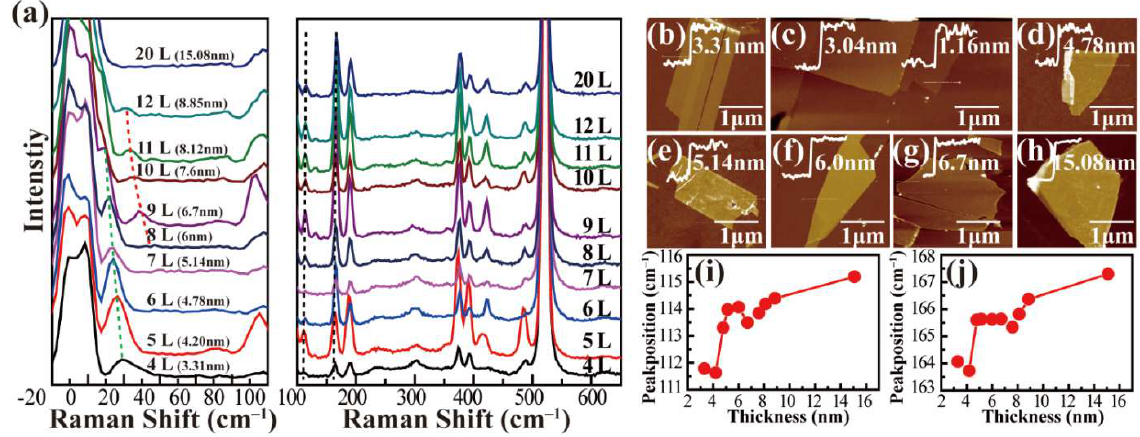
Figure 3. ( a ) Low wavenumber and high wavenumber Raman spectra of several layers of SiAs crystals with decreasing thickness after mechanical peeling. ( b – h ) AFM measurement results of some typical SiAs crystals from thin to thick in the Raman spectroscopy. ( i , j ) Trends in the positions of 112 cm –1 and 169 cm –1 fitted peaks of SiAs crystal with increasing thickness.